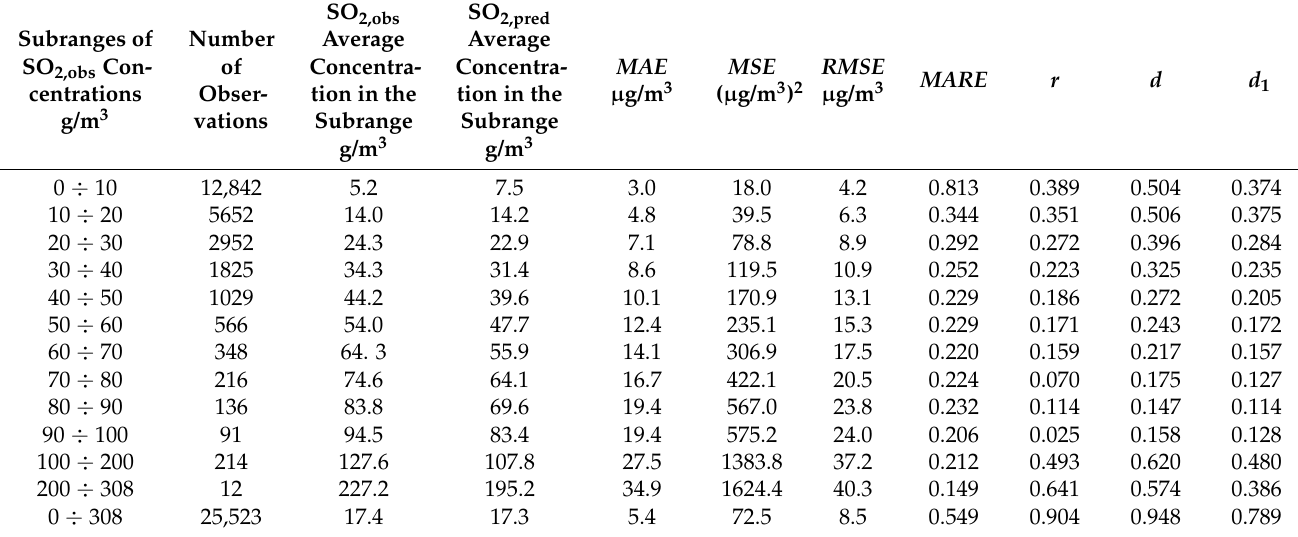
Table 5. Values of approximation errors calculated for different subranges and the entire range of SO 2,obs concentrations (hourly data, Zabrze 2011–2016), SO 2,obs means real SO 2 concentration, and SO 2,pred means predicted SO 2 concentration.